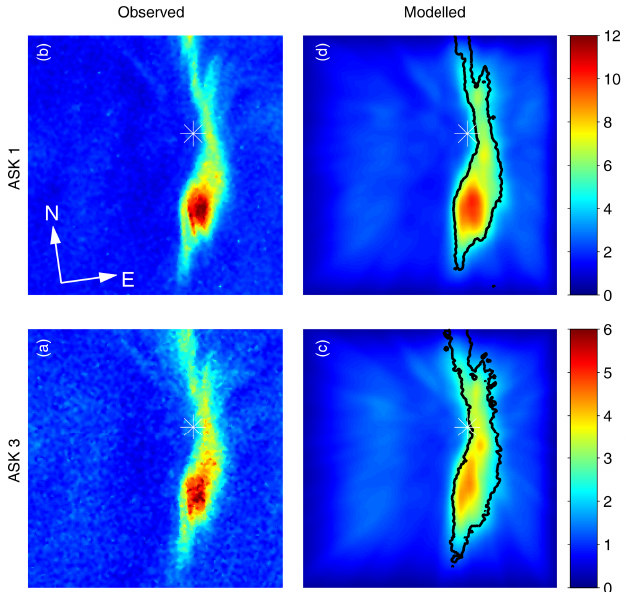
Figure 11. Observed (a, c) and modelled (b, d) images of the au- roral brightness I 673 . 0 (a, b) and I 777 . 4 (c, d) at 21:25:06 UT. The black lines on the modelled images are intensity contours of the ob- served images at 4kR (I 673 . 0 ) and 2kR (I 777 . 4 ). The white asterisks indicate the position of the magnetic